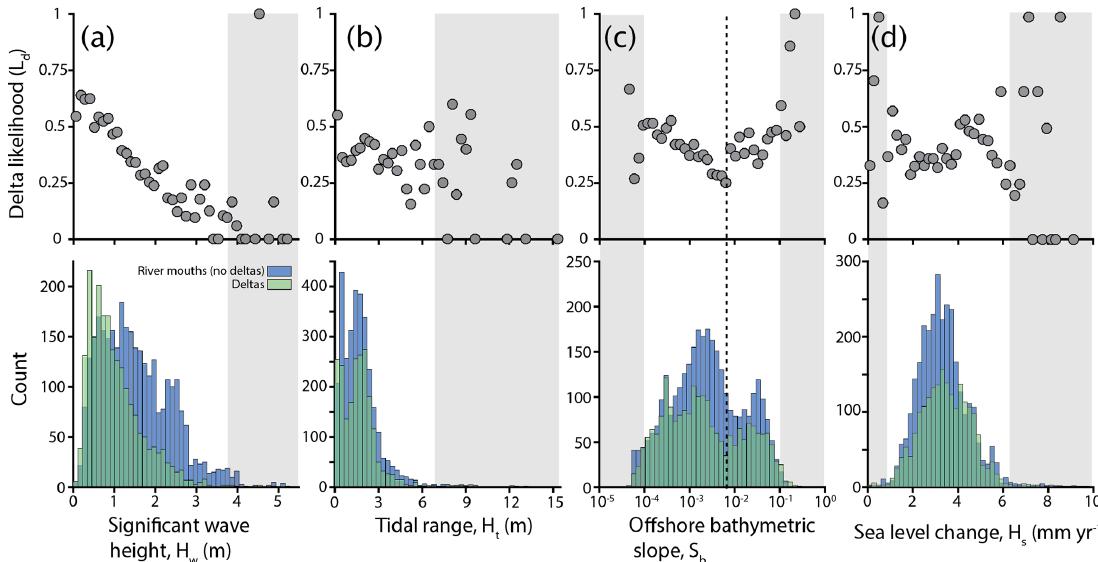
Figure 6. Differences in downstream environmental variables for rivers with and without deltas. Scatter plots (top of each panel) of delta likelihood, defined as the number of rivers with a delta relative to the total number of rivers in that interval. Histograms (bottom of each panel) binned into equal log-spaced intervals. Gray boxes outline ranges represented by 1% or less of the total sample number. Sea level change plot and histogram (d) only include positive values due to limited negative